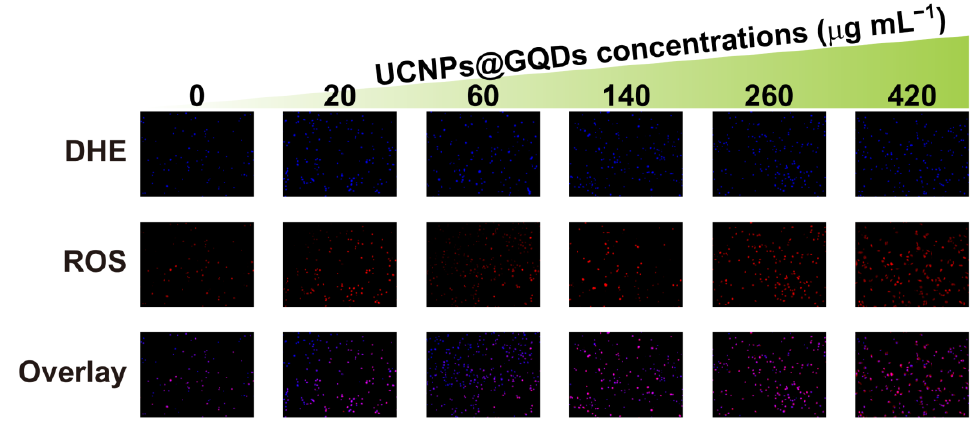
Figure 4. PDT assessment for UCNPs@GQDs. ( a ) Biocompatibility of UCNPs@GQDs was assessed without irradiation of a 980 nm laser. ( b ) Cell viability of HeLa cells treated by UCNPs@GQDs was determined by Live/Dead assay kit.